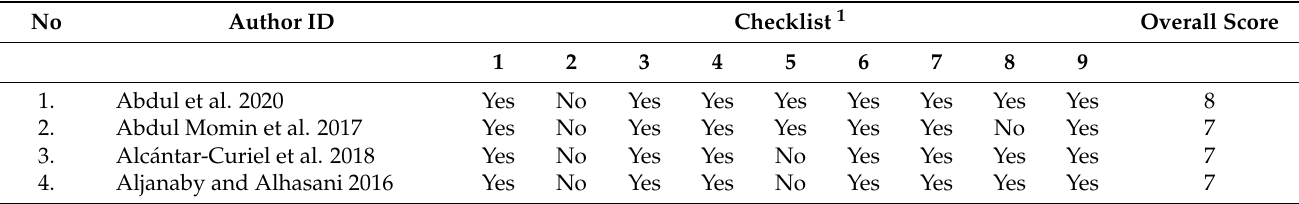
Table A1. Quality of the included studies by the JBI critical appraisal checklist for studies reporting prevalence